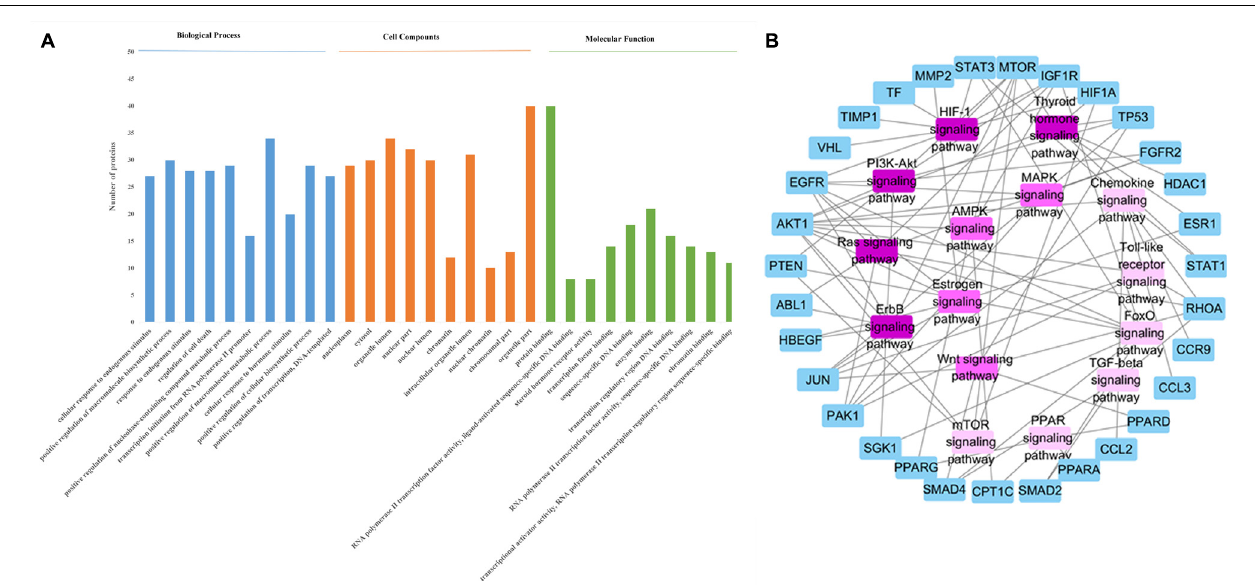
FIGURE 3 | (A) The enrichment analysis in biological processes, cellular components and molecular functions of 79 identified target proteins by STRING database. (B) The Target protein-Pathway network. Blue nodes refer to target proteins. The pink nodes represent pathways, and the color is consistent with pathways related target protein numbers, the deeper the pink, the more number of proteins.